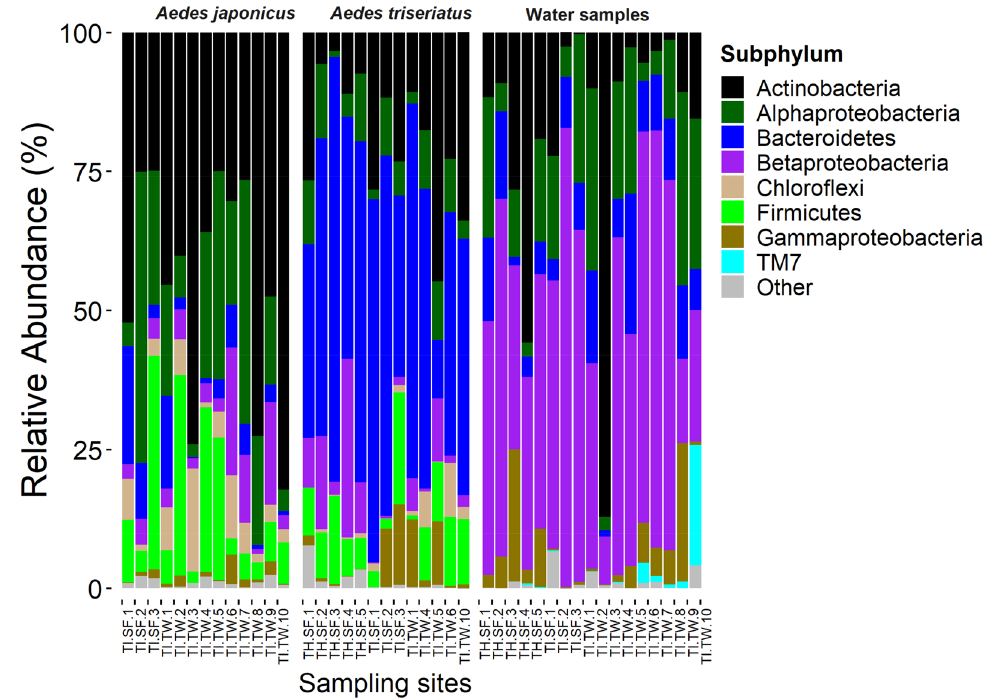
Figure 1. Composition of bacterial communities in mosquito and water samples collected from individual sampling sites at Trelease Woods and South Farms, Urbana, IL. Data represent taxonomic classification at subphylum level. Taxa with sequence abundance < 1% of total sequences were pooled together as “Other” in all the taxonomic ranks. TI used tire, TH tree-hole, SF South Farm, TW Trelease